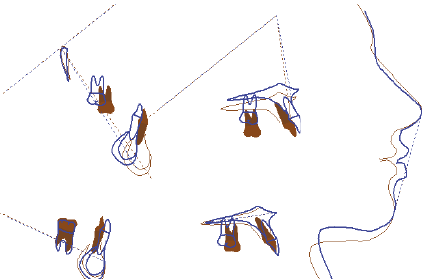
Figure 7: Superimpositions (blue: pretreatment; red: posttreat-